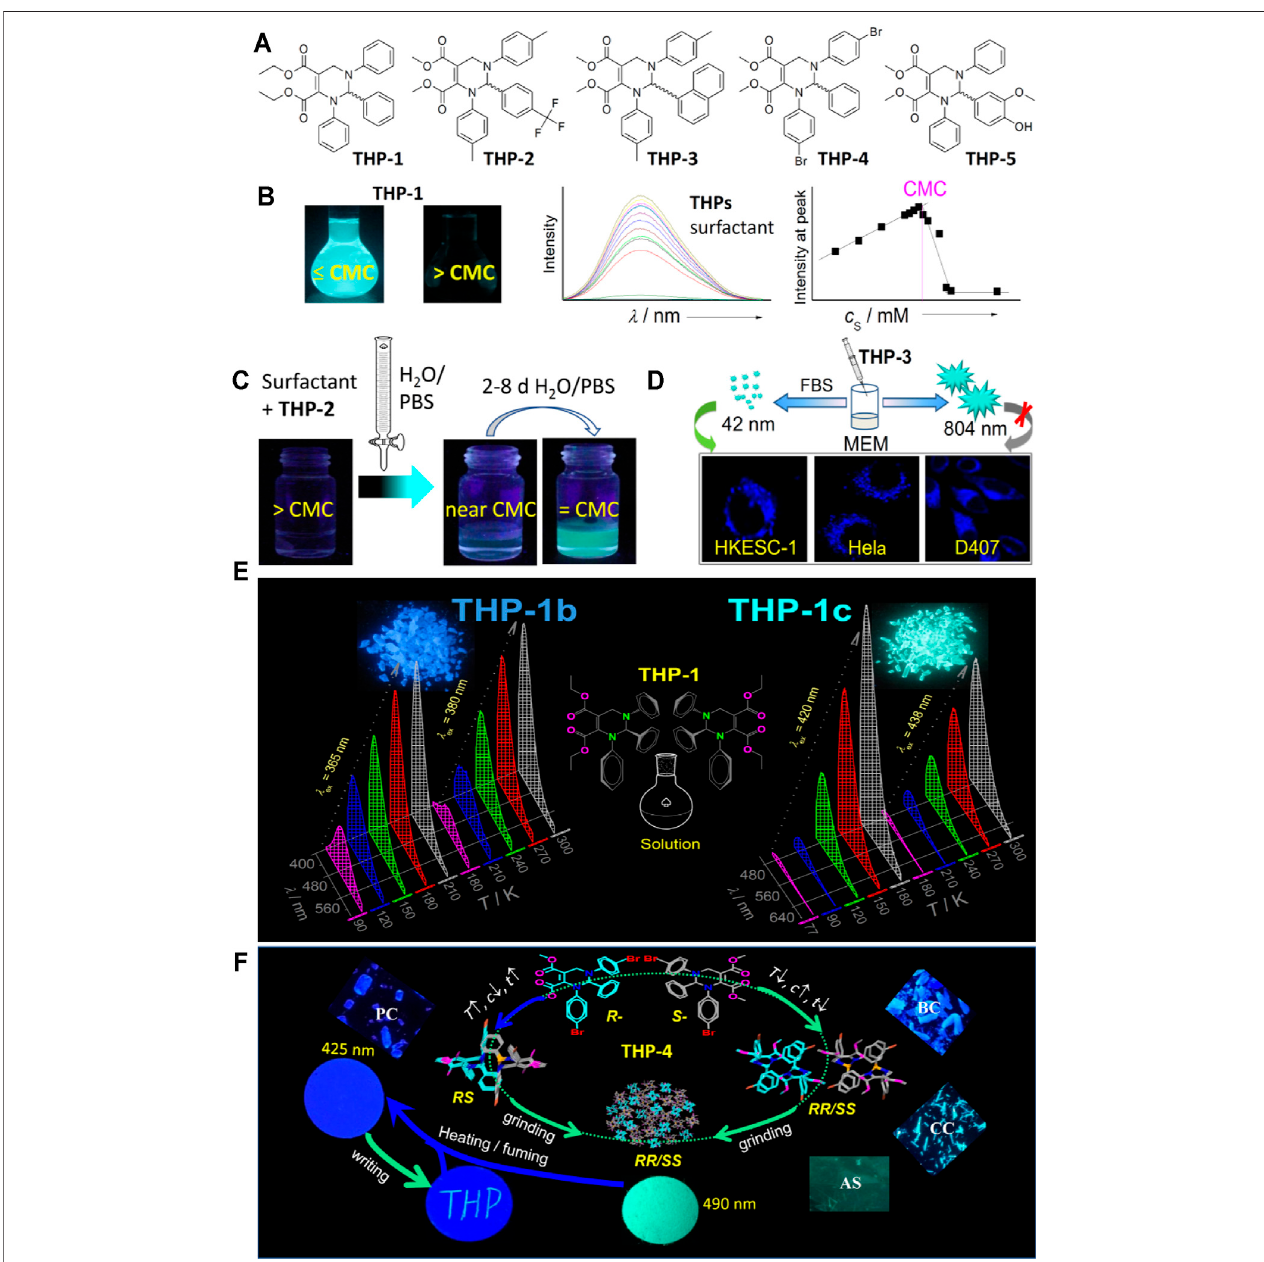
FIGURE 2 | Applications of some THPs based on AIE and on AIE and other characteristics. (A) Molecular structures. (B) Photos of THP-1 in surfactant solutions with concentrationlowerthanorequaltocriticalmicelleconcentration(CMC)andhigherthanCMC,respectively.TheemissionspectraofTHPsindifferentconcentrationsofsurfactant solutionsaswellastherelationshipbetweenthe fl uorescenceintensityofTHPsatpeak(Zhuetal.,2014;Caietal.,2015).ReproducedwithpermissionfromtheRoyalSocietyof Chemistry. (C) Schematicprocessof THP-2 as fl uorescenceindicatorforCMCtitration(Wuetal.,2020).ReproducedwiththepermissionofAmericanChemicalSociety. (D) Schematicpreparation of THP-3 nanoparticles by adding10% fetal bovine serum (PBS) in cellculturemedium minimum essentialmedium (MEM) and the confocal microscopic imaging of living HKESC-1, Hela, and D407 cells incubated with the as-prepared THP-3 nanosuspension (Zheng et al., 2018). Reproduced with the permission of Elsevier. (E) Photosof THP-1 inpolymorphs 1b and 1c ,andtheiremissionspectraatdifferenttemperaturesindifferenttemperaturerangesexcitedatdifferentwavelengths(365and380 nm for 1b ,and420and438 nmfor 1c )(Zhuetal.,2016).Symbolsbandcrepresentblueandcyan fl uorescence,respectively.ReproducedwithpermissionfromtheRoyalSocietyof Chemistry. (F) Schematicformationprocessof THP-4 polymorphsbydifferentpackingmodesof R -and S -enantiomers,andthemechano fl uoromaticcharacteristicsanduseof THP-4 as erasable material (Liu et al., 2017). PC, purple crystals; BC, blue crystals; CC, cyan crystals; AS, amorphous state. All photos were taken under a UV light (365 nm). Reproduced with the permission of Elsevier.